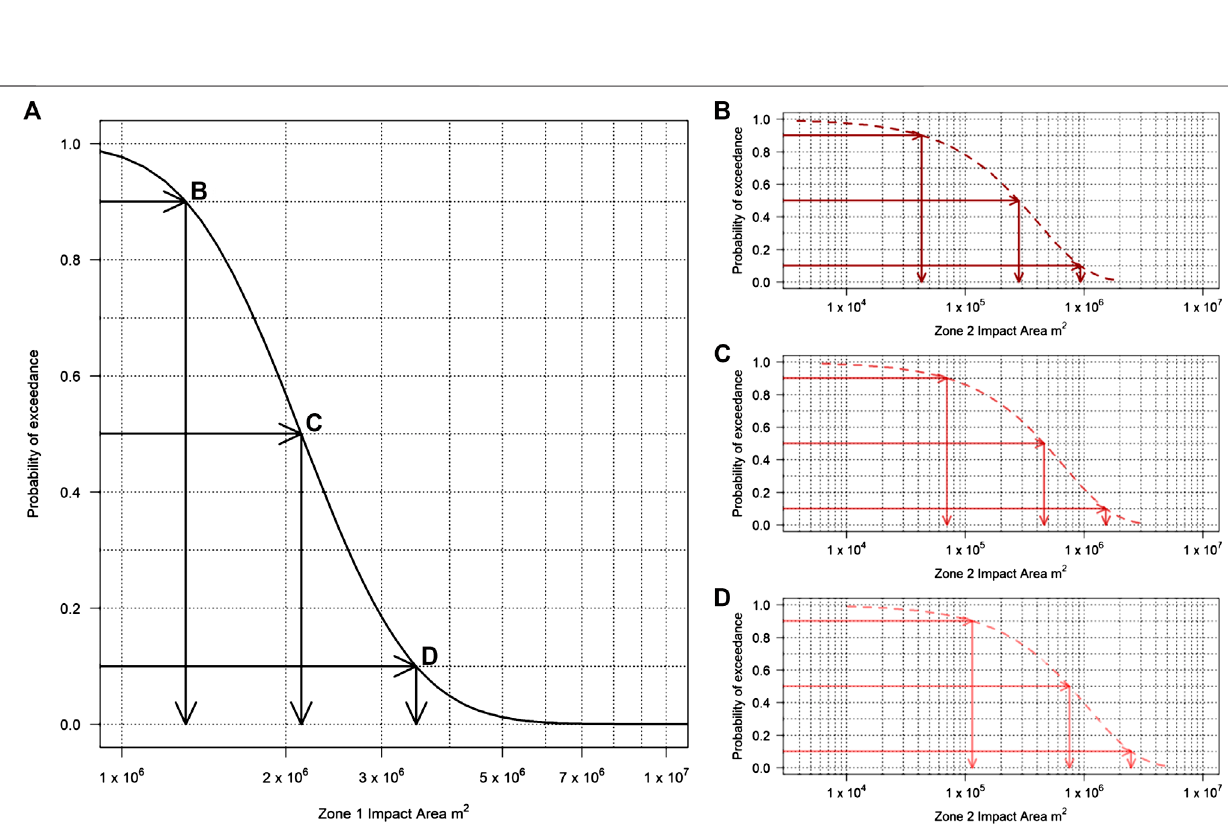
Frontiers in Earth Science |